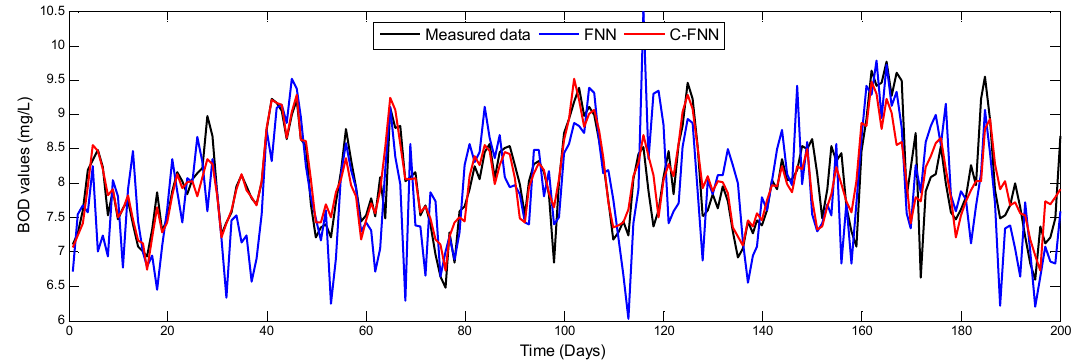
Figure 11. The testing output of the FNN, C ‐ FNN for BOD.